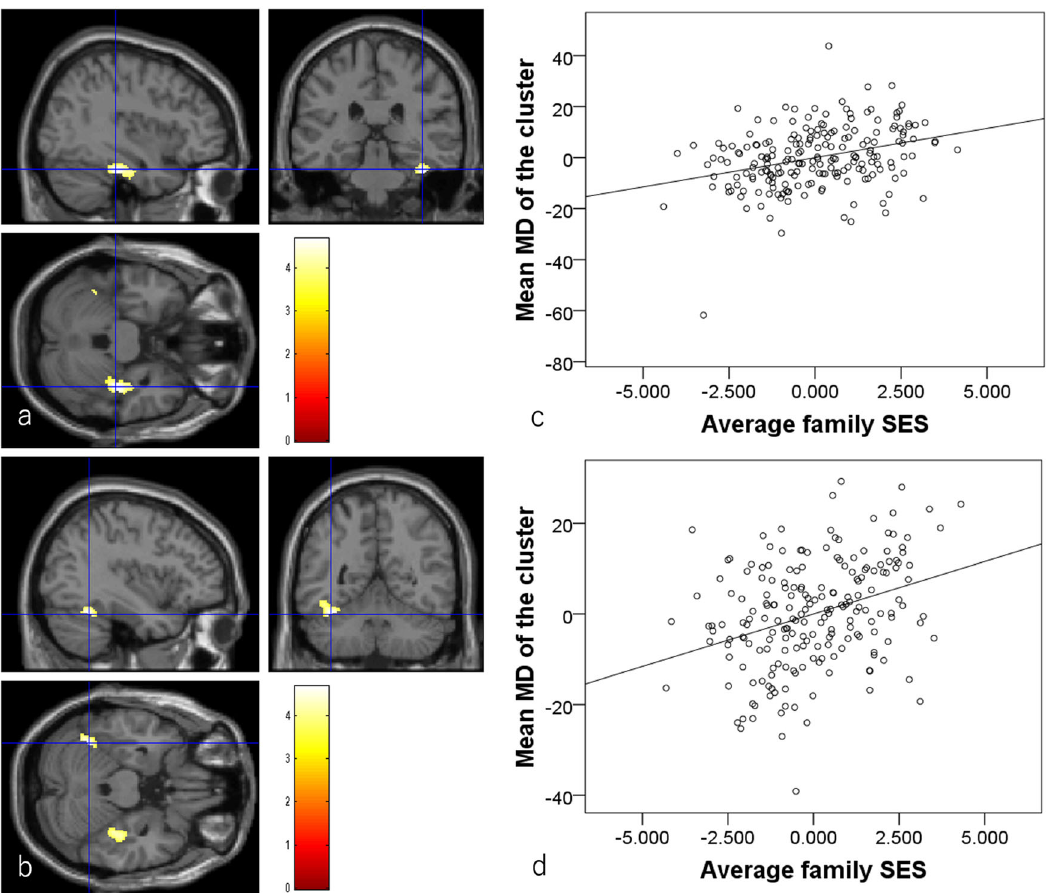
Fig. 6 Associations between greater baseline to follow-up experimental MD changes and higher childhood SES in the longitudinal analysis ( N = 200). a , b Areas of signi fi cant associations between greater MD change and higher childhood SES. Results are shown using a threshold of P < 0.05 corrected for multiple comparisons in cluster size tests, with a voxel-level cluster determining threshold of P < 0.05 (corrected for FDR). Results were corrected at the whole-brain level. Regions with signi fi cant correlations were overlaid on a “ single participant ” T1 image. The color represents the strength of the T value. Signi fi cant associations were observed in the anatomical cluster that primarily spread around the bilateral fusiform gyrus. c , d Partial residual plots with trend lines depicting associations between residuals in the multiple regression analyses. The mean MD from the signi fi cant clusters shown in ( a ) and ( b ) respectively were used as the dependent variables and childhood SES was the independent variable. Note as described in Methods, when the baseline value is adjusted in the multiple regression analyses, whether baseline to follow-up experimental value changes are used or follow-up experimental values are used as dependent variables, the p and t values will be the same. And since in this analysis, baseline to follow-up experimental time interval are adjusted, the displayed plots are not affected by the time